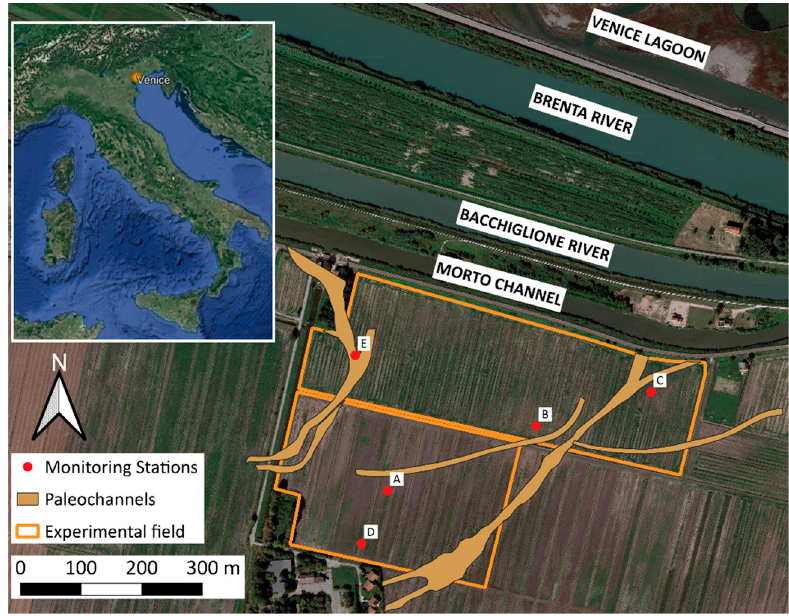
Figure 1. Map of the study area depicting the paleochannels and the monitoring stations.